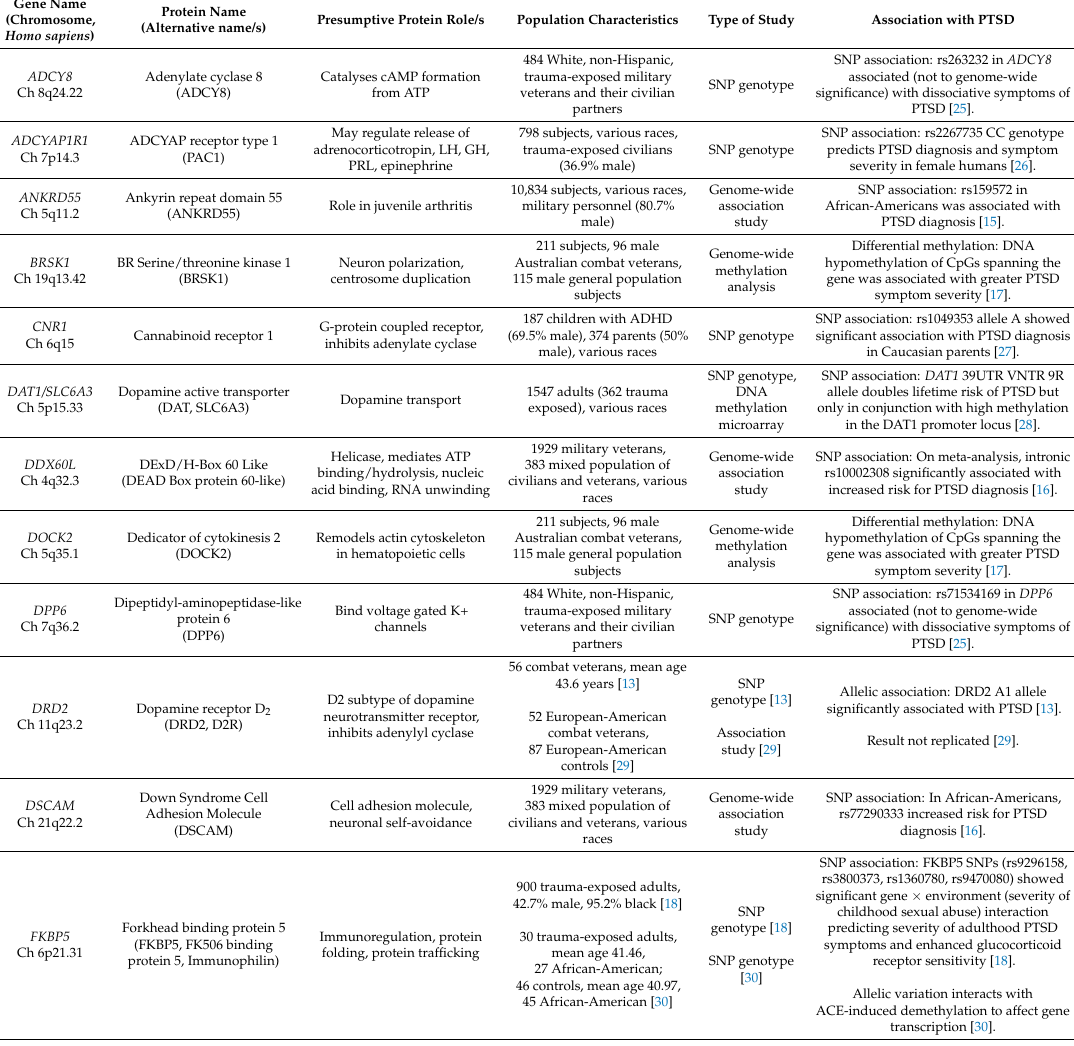
Table 1. A reported list of protein-coding genes reportedly associated with either an elevated risk of post-traumatic stress disorder (PTSD) or an increased severity of the clinical phenotype of PTSD in human populations. SNP: Single nucleotide